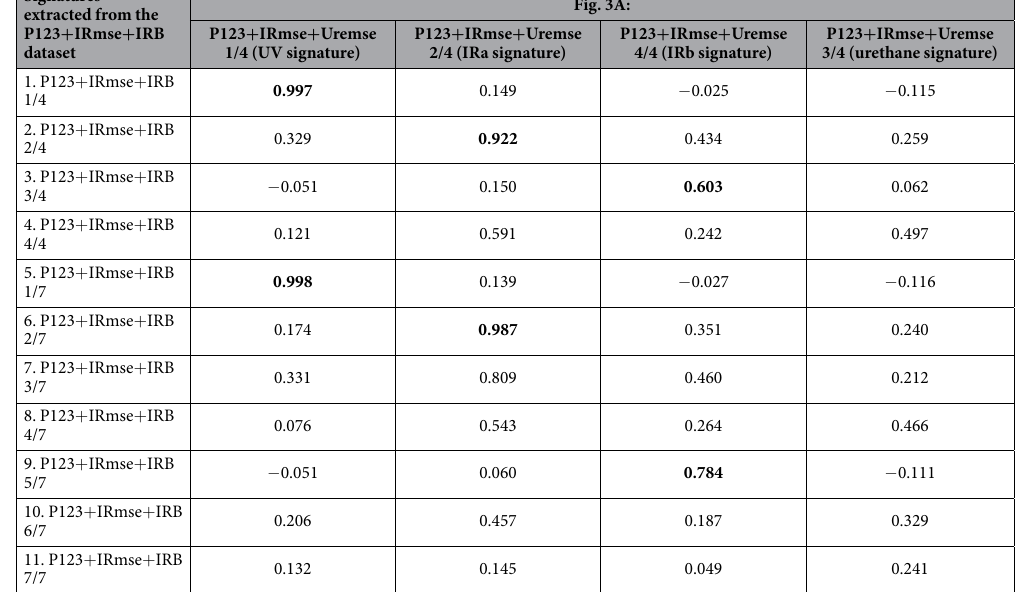
Table 3. Effect of including WTSI irradiated samples. Correlations of signature coefficients from P123 + IRmse + Uremse 4-signature analysis with each other and the sample including the 12 WTSI irradiated samples, P123 + IRmse +